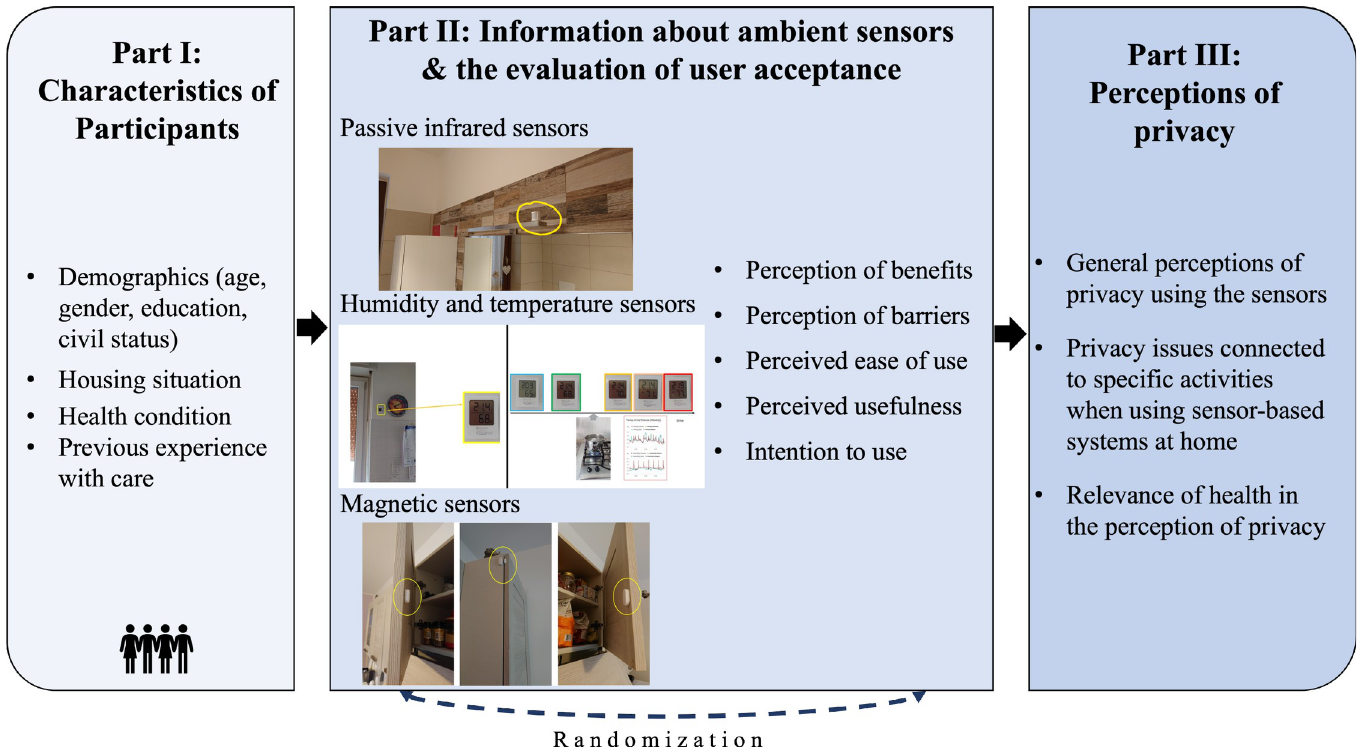
Fig 2. Schematic structure of the online